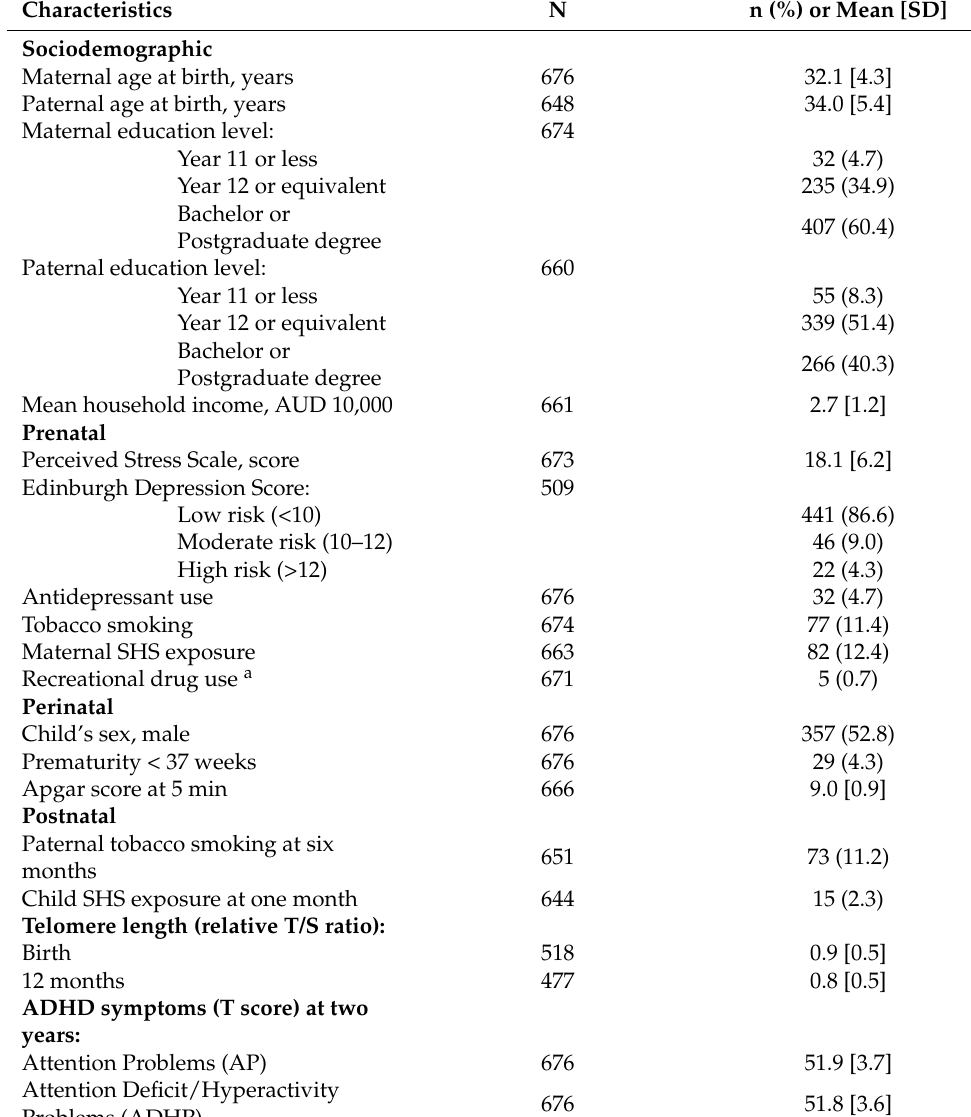
Table 1. Participant characteristics in the Barwon Infant